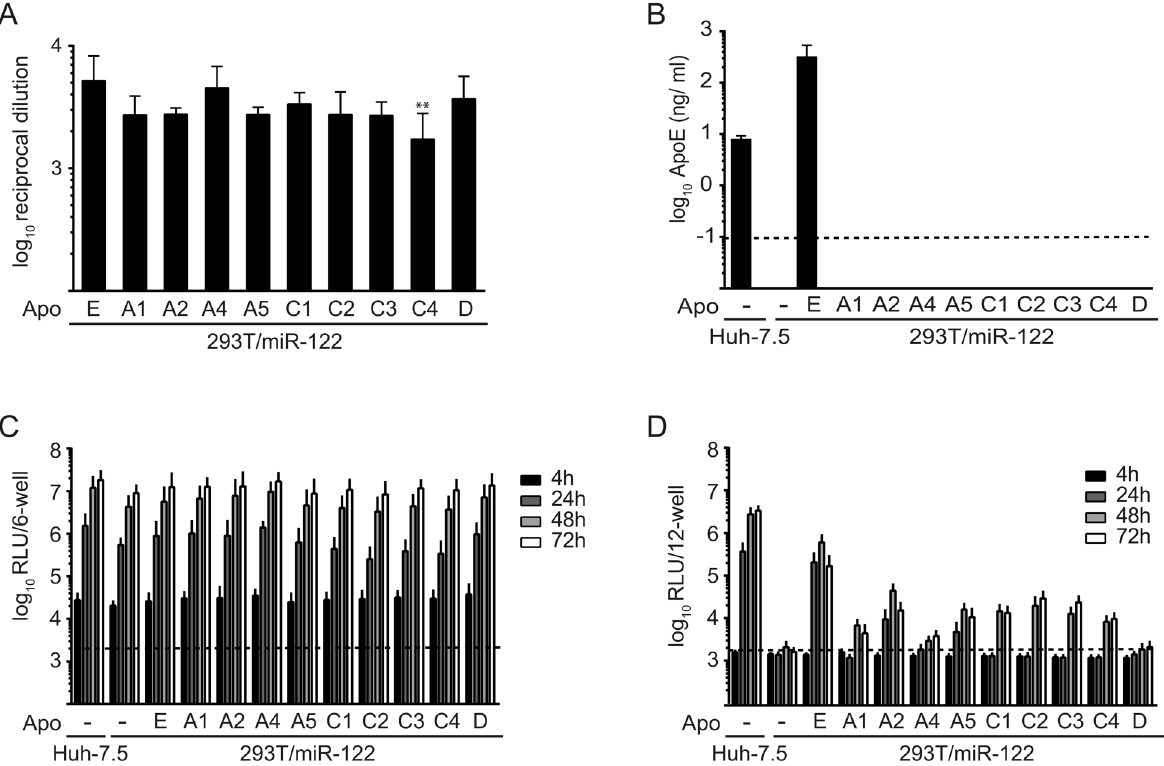
Fig 2. Ectopic expression of various exchangeable apolipoproteins in 293T/miR-122 cells restores production of infectious HCV particles. A: Depicted are reciprocal dilutions of secreted HA-tagged apolipoproteins that reach an OD of 2-fold over background (293T/miR-122 cells expressing an empty vector). Differences in secretion of individual apolipoproteins compared to ApoE were analyzed using one way ANOVA associated with Dunnett ’ s multicomparison test. Significant changes are indicated by asterisk ( ** = p < 0.01). B: Amounts of secreted ApoE (ng/ ml) in cell culture fluids were determined with a commercially available ELISA kit. The dashed line indicates the limit of detection. C: Cell lines were transfected with JcR2A HCV RNA encoding a Renill a luciferase reporter. HCV RNA replication was determined at 4 h, 24 h, 48 h and 72 h post transfection by luciferase measurements in the cell lysates and is expressed as relative light units (RLU). D: Cell-free culture fluids of transfected cells from (C) were used to inoculate na ï ve Huh-7.5 cells and infectivity was determined by luciferase assay at 72 h post inoculation. For panels (A), (B), (C), and (D) results are means and standard deviations (SD) of three independent